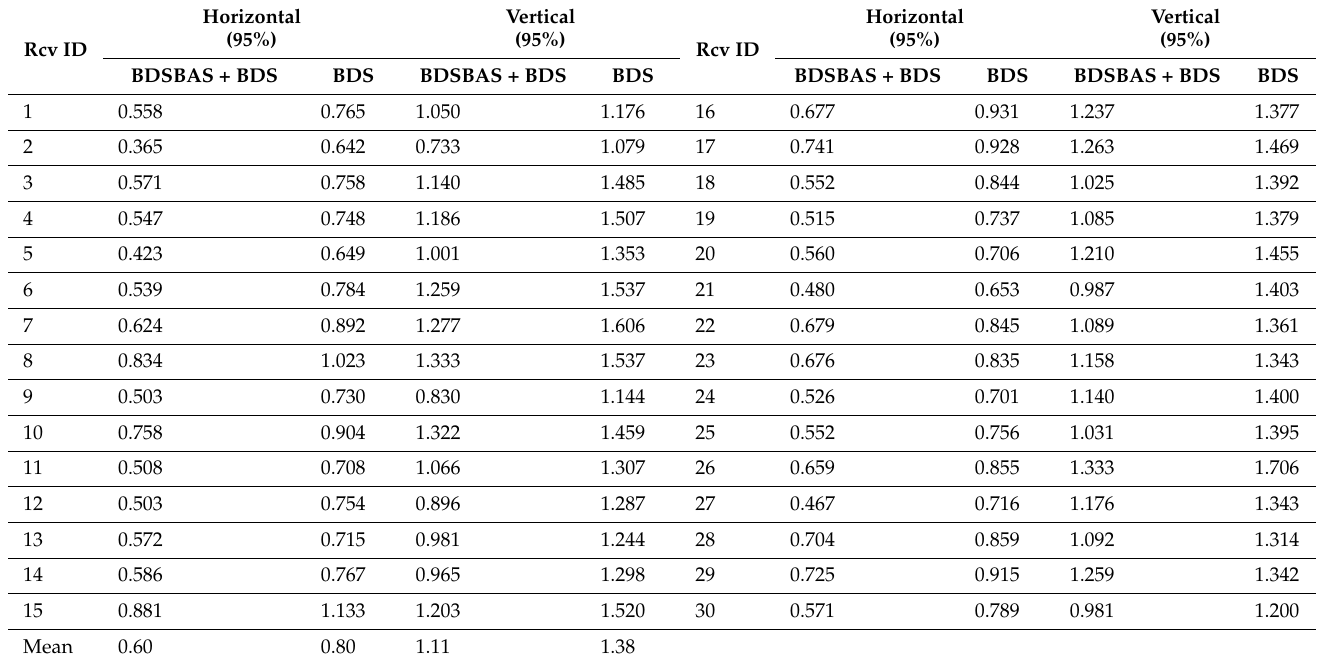
Table 3. The position accuracy comparison under the BDSBAS DFMC service and the BDS dual- frequency service (unit is